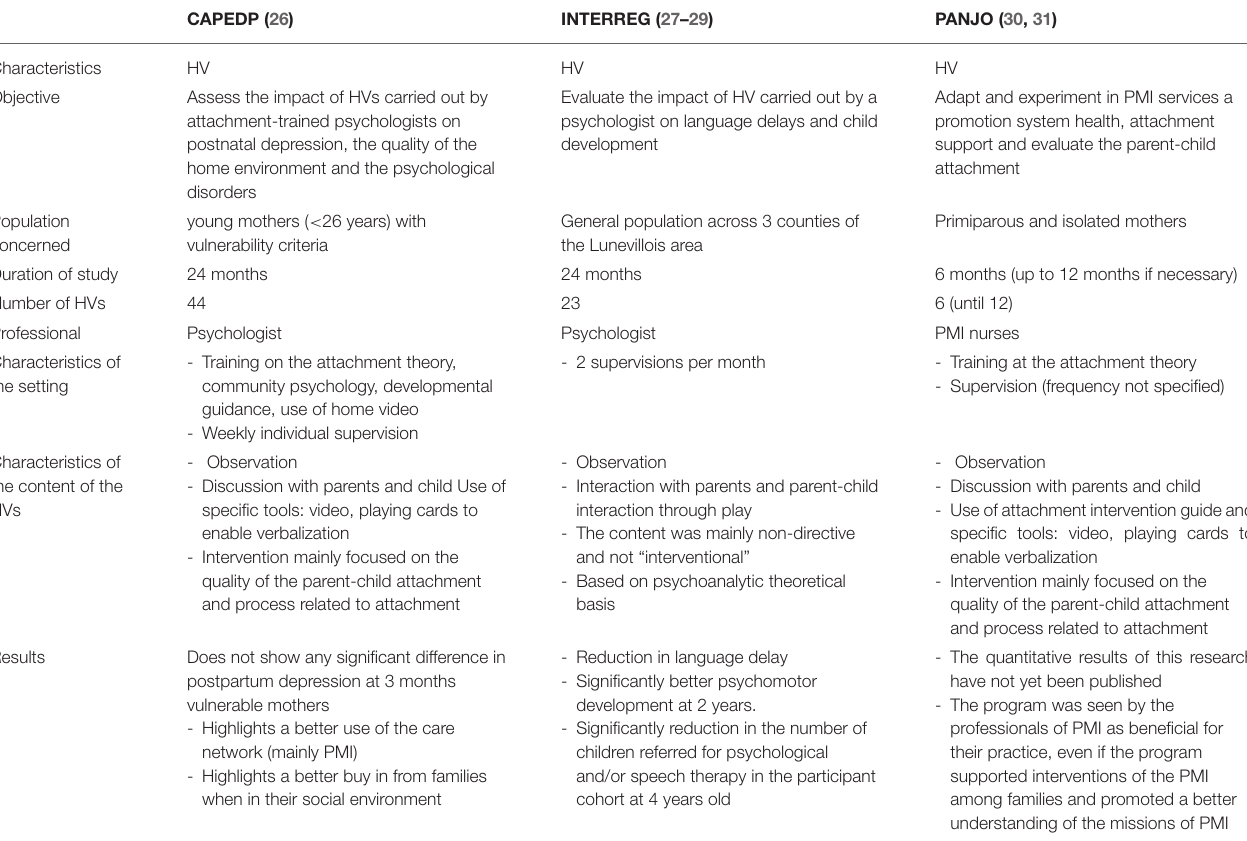
TABLE 1 | French research on